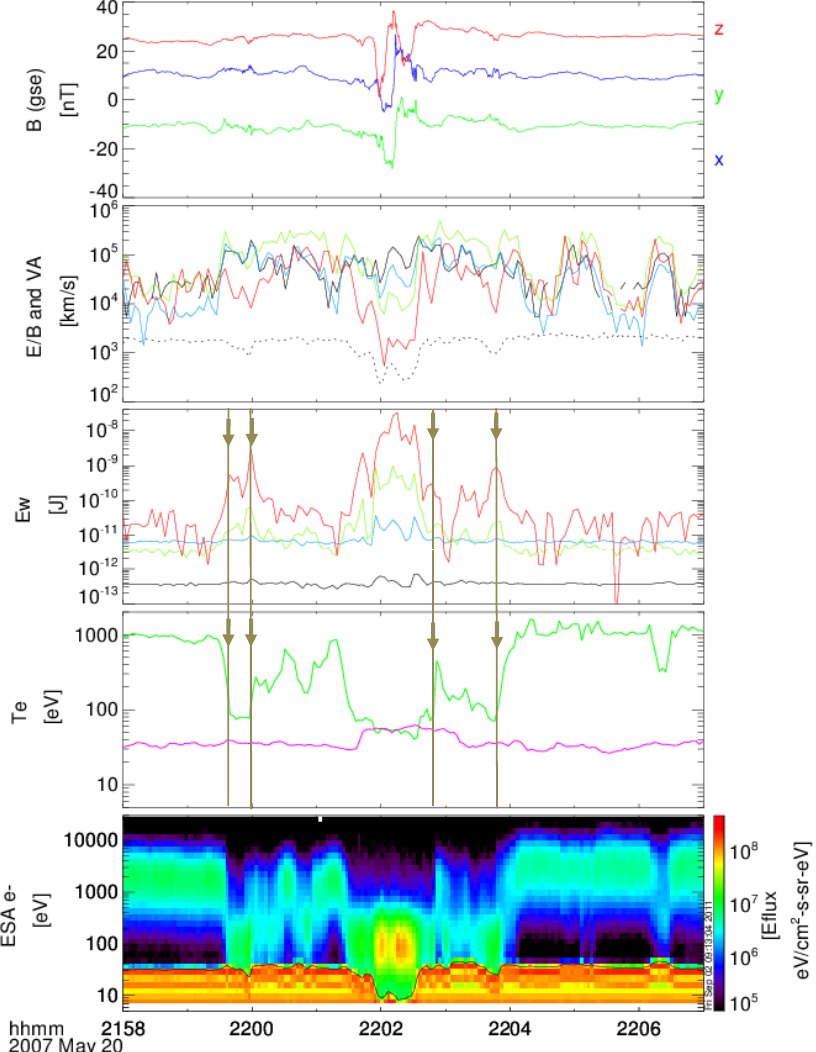
Fig. 6. This figure shows mainly data from Thc. From top to bottom: (a) the 3 components of the magnetic field, (b) δE/δB for different frequencies (3Hz in red, 12 in green, 48 in cyan and 192Hz in black) and V a (dotted line), (c) Ew the electromagnetic energy, (d) T e for Thc (green) and Tha (magenta). The bottom panel shows a spectrogram from Thc; the spacecraft moves back and forth from the MSp to the MpCL. The thin vertical lines and superposed arrows point out the coincidences between sharp gradients in T e and wave